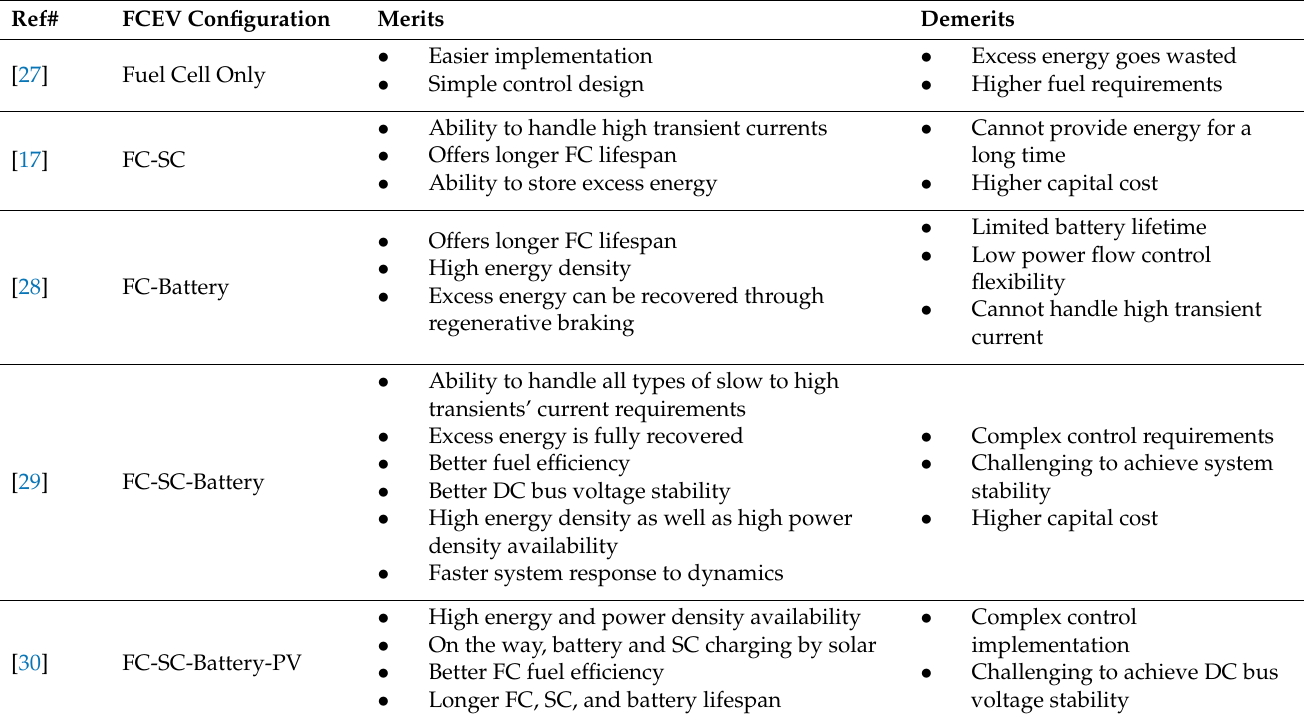
Table 1. Major FCEV configurations and their